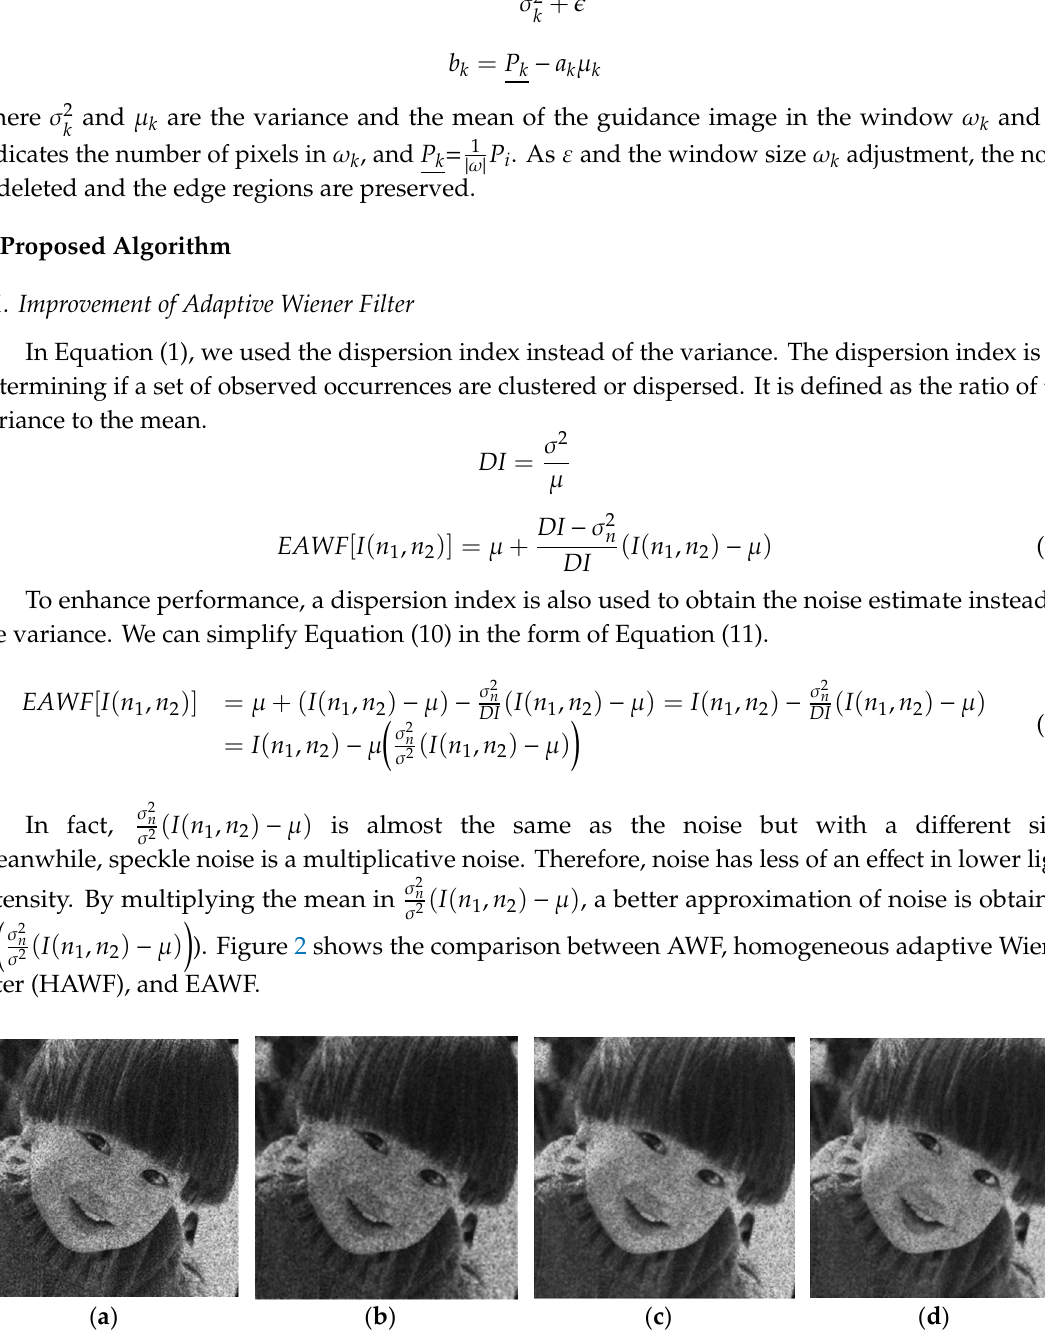
Figure 2. ( a ) Noisy image ( σ 2 = 0.3), ( b ) homogeneous adaptive Wiener filter (HAWF), ( c ) adaptive Wiener filter (AWF), ( d ) extended adaptive Wiener filter (EAWF).